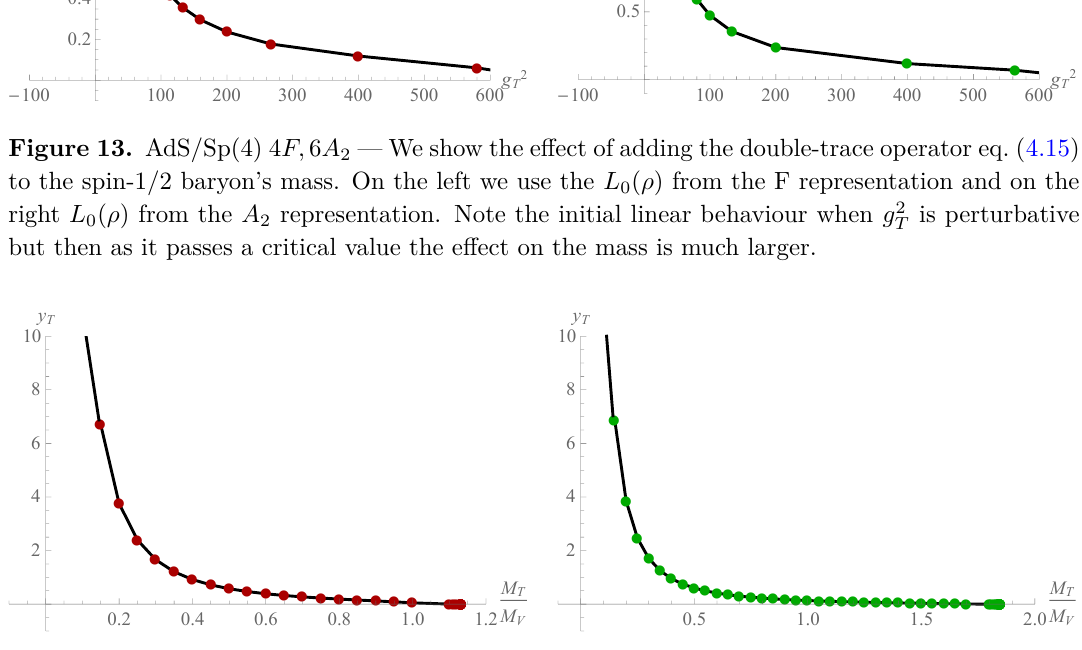
Figure 14. AdS/ Sp(4) 4 F, 6 A 2 — the top Yukawa coupling, as given by (4.12), is plotted against the top partner mass in units of the vector meson mass. M T is controlled by adding a HDO as in figure 13. We compute on the left with L 0 ( ρ ) for the fundamental quark and on the right we use the A 2 L 0 ( ρ )